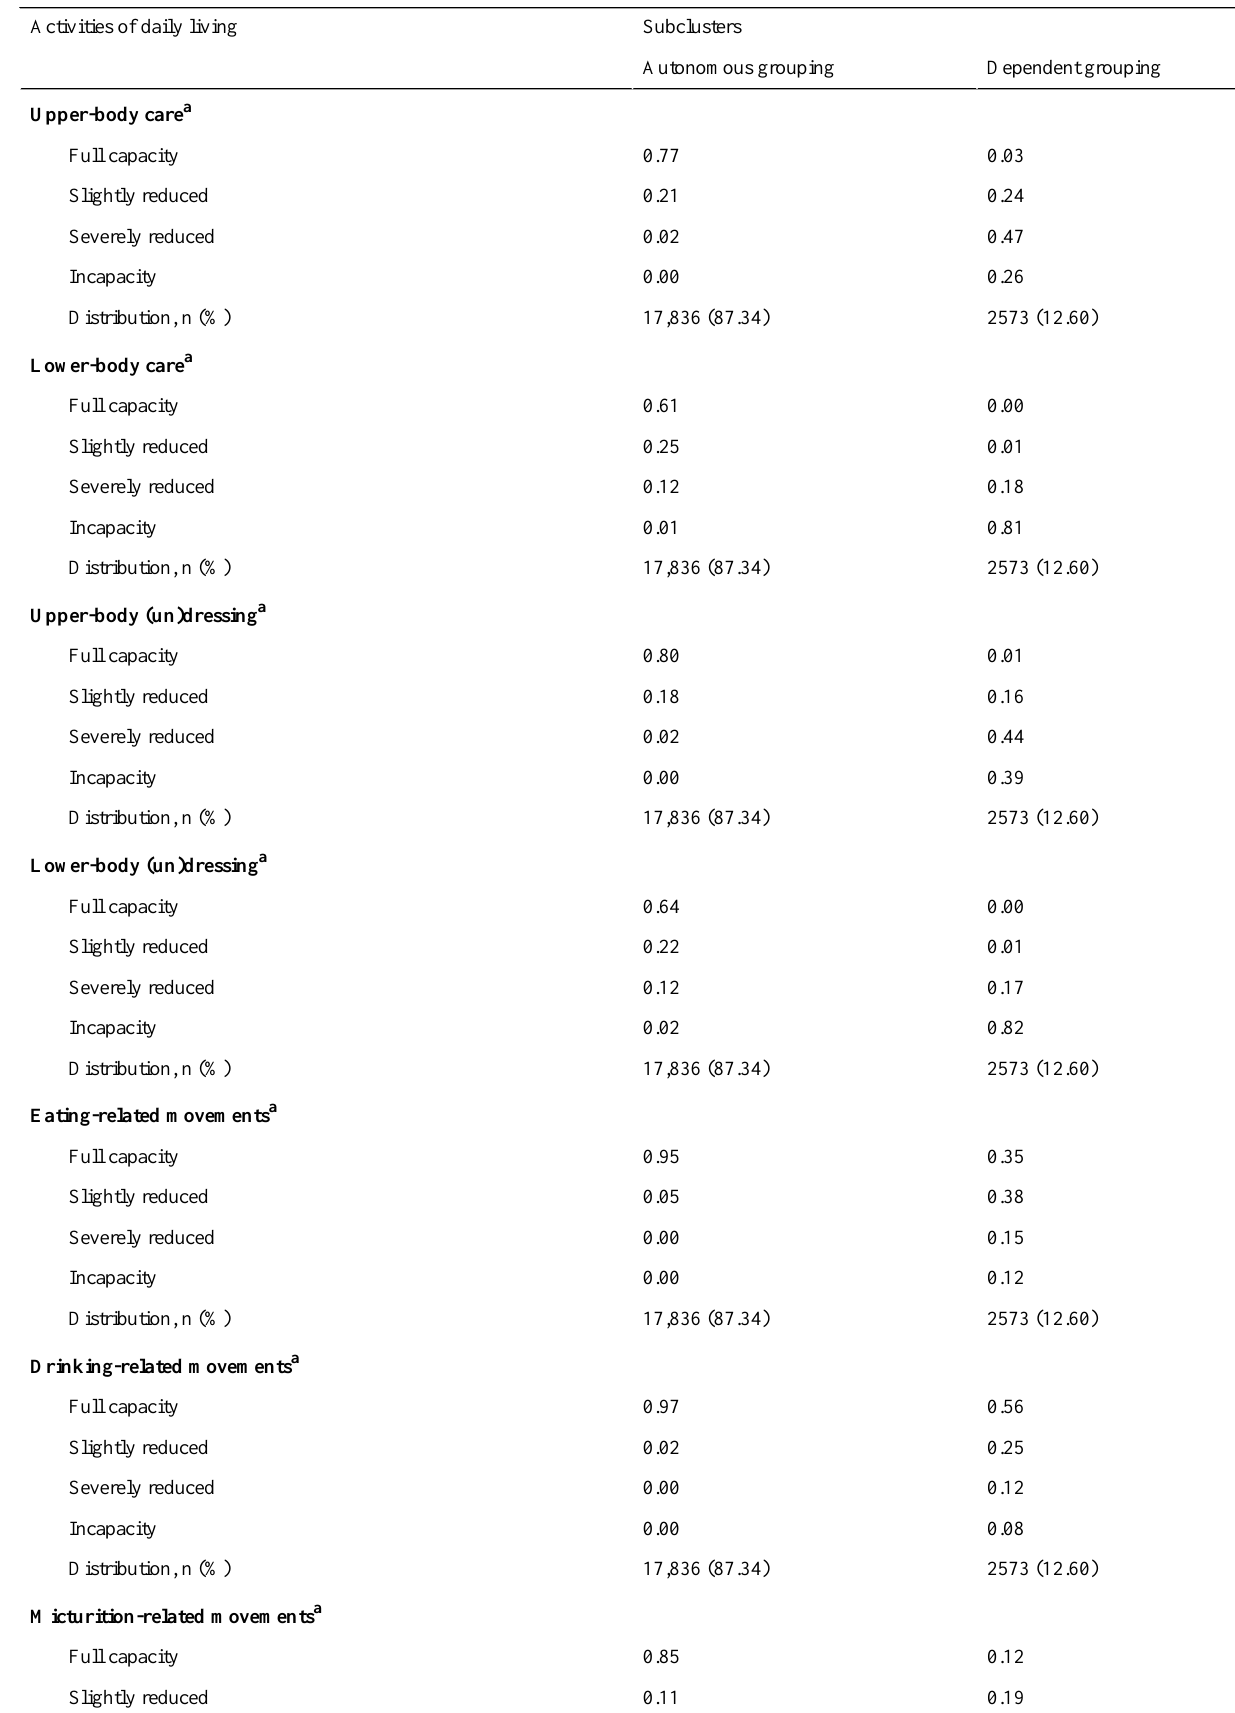
Dependent groupingAutonomous grouping